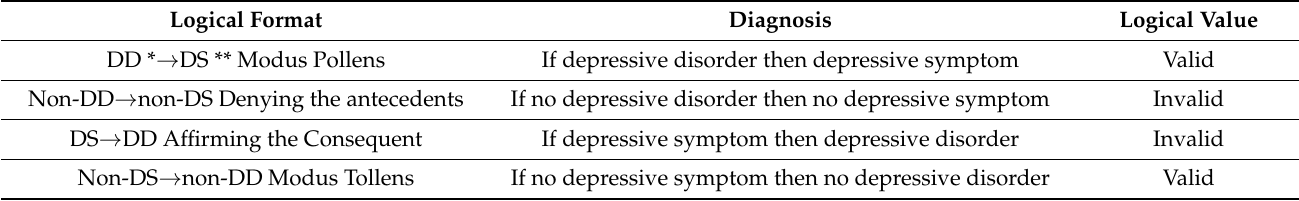
Table 1. The four formats of conditional